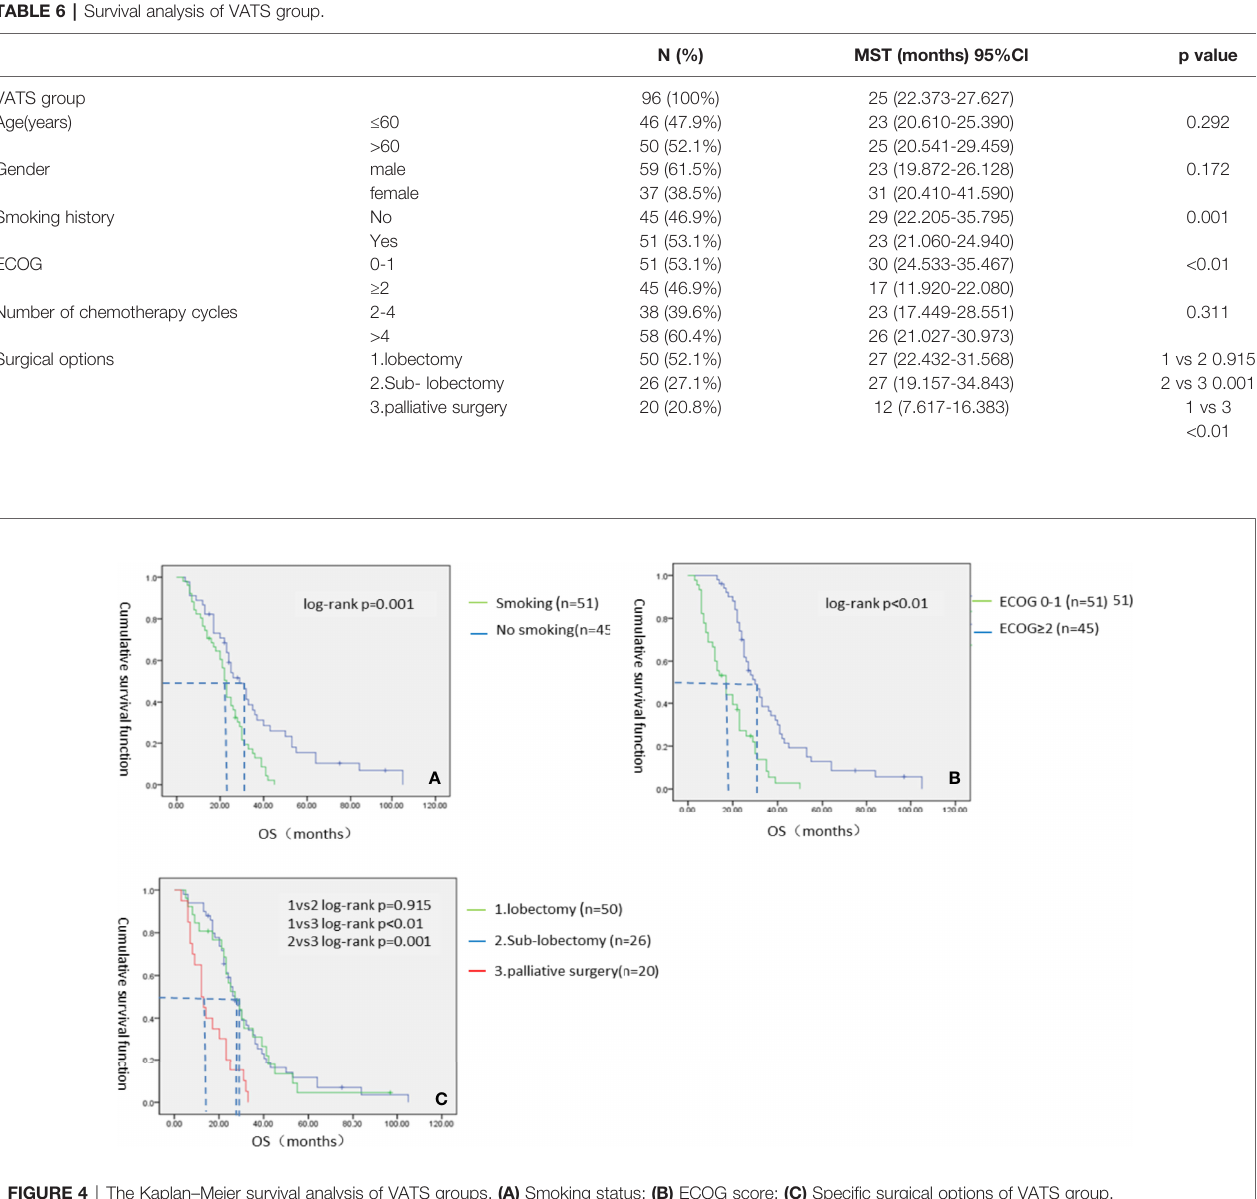
FIGURE 4 | The Kaplan – Meier survival analysis of VATS groups. (A) Smoking status; (B) ECOG score; (C) Speci fi c surgical options of VATS